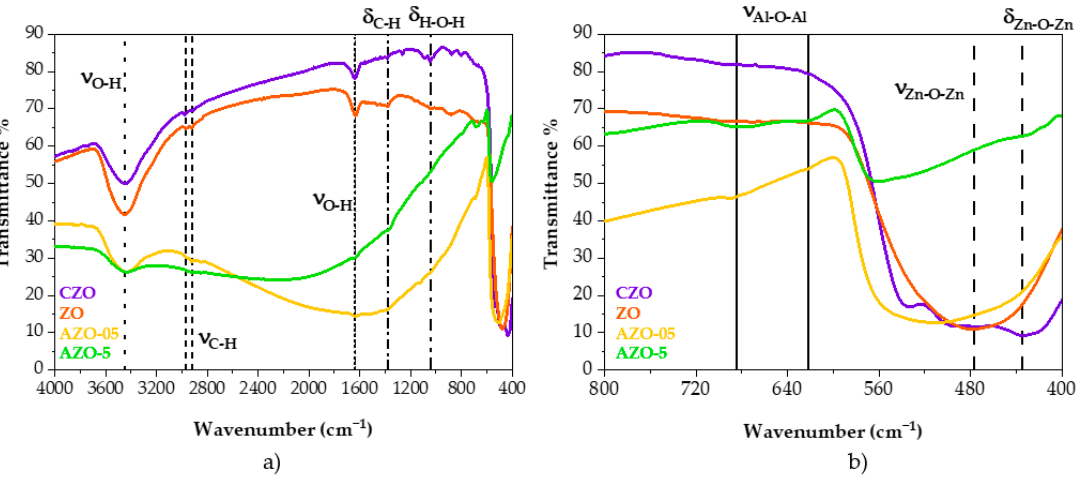
Figure 4. FT-IR spectra of quasi-spherical CZO, ZO, AZO-05 and AZO-5 not-annealed nanoparticles, ( a ). Magnification of the FT-IR fingerprint zone, ( b ).